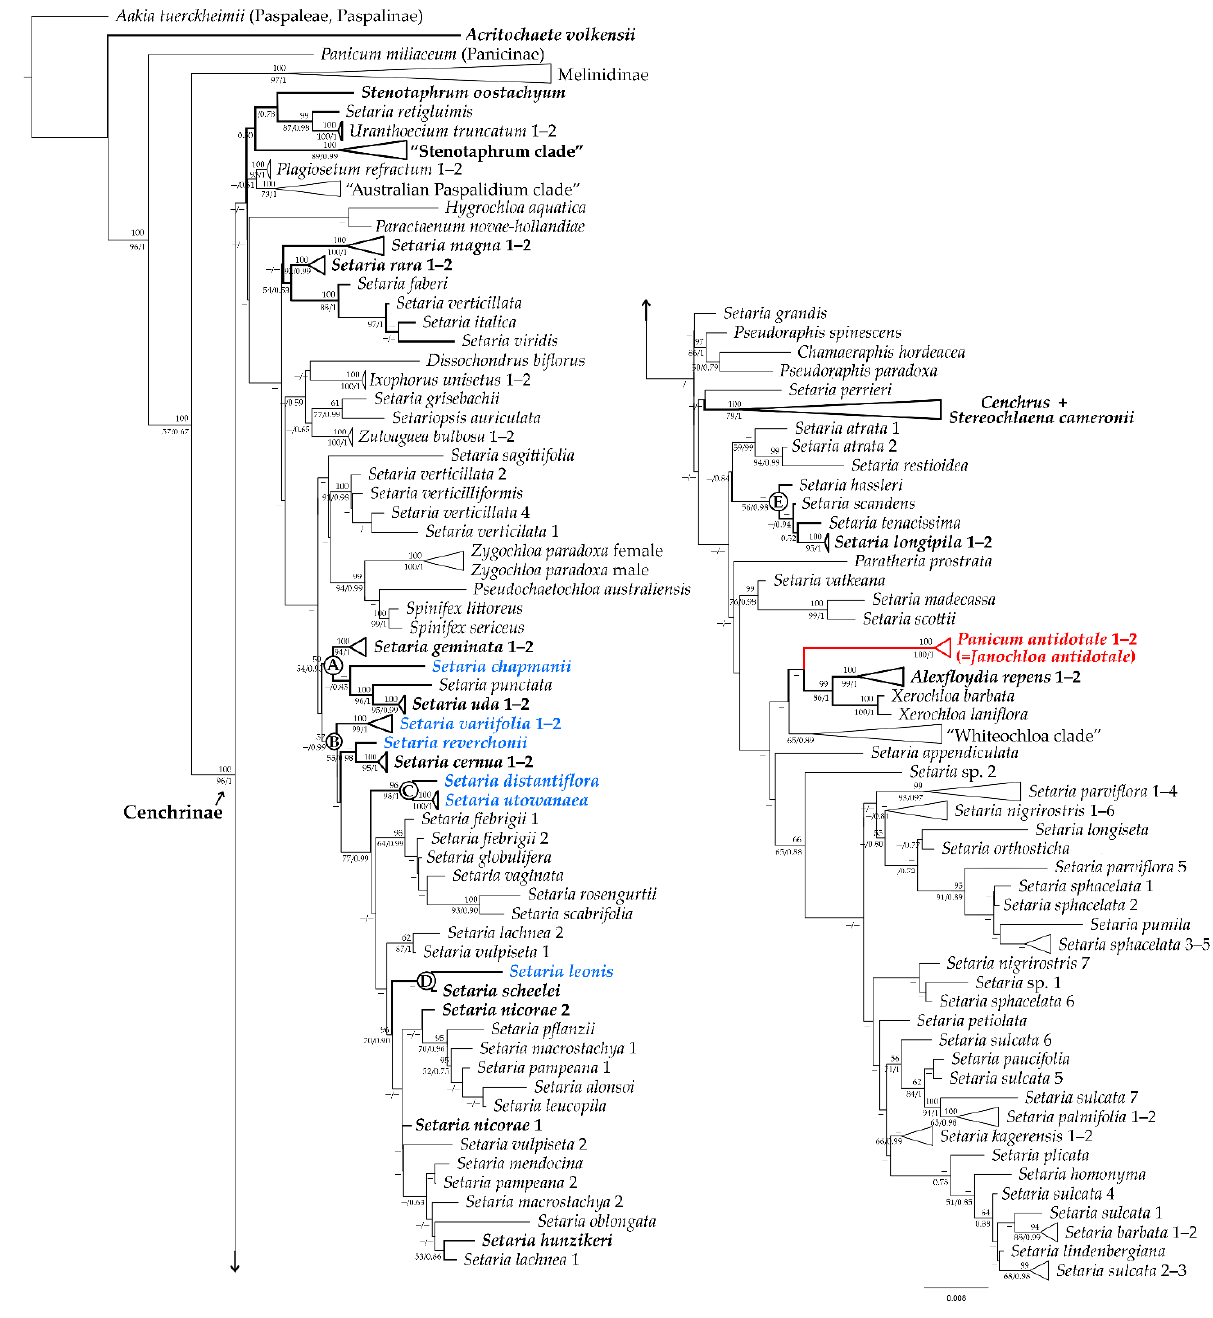
Figure 1. Maximum Clade Credibility Tree (MCCT) from the Bayesian inference analysis based on the chloroplast ndh F gene. Bootstrap supports from parsimony are listed above the branches and bootstrap supports from maximum likelihood/posterior probabilities from Bayesian inference are listed below the branches. Nodes with “–” have posterior probabilities and bootstrap supports <0.50 and <50%, respectively. Clades/taxa in bold and/or denoted by letters are discussed in the text. The new genus, Janochloa Zuloaga & Delfini, is highlighted in red, and the species of subgenera Paurochaetium and Reverchoniae of Setaria in blue. Clade A is a strongly supported clade in BI (BPP 0.93/MLB 54/PB 59), including the two accessions of S. uda (BPP 0.99/MLB 95/PB 100) as sisters to Setaria punctata (Burm. f.) Veldkamp (BPP 1/MLB 96/PB 100), and both related to Setaria chapmanii (Vasey) Pilg. (BPP 0.85/MLB < 50/PB < 50); the two accessions of Setaria geminata (Forssk.) Veldkamp